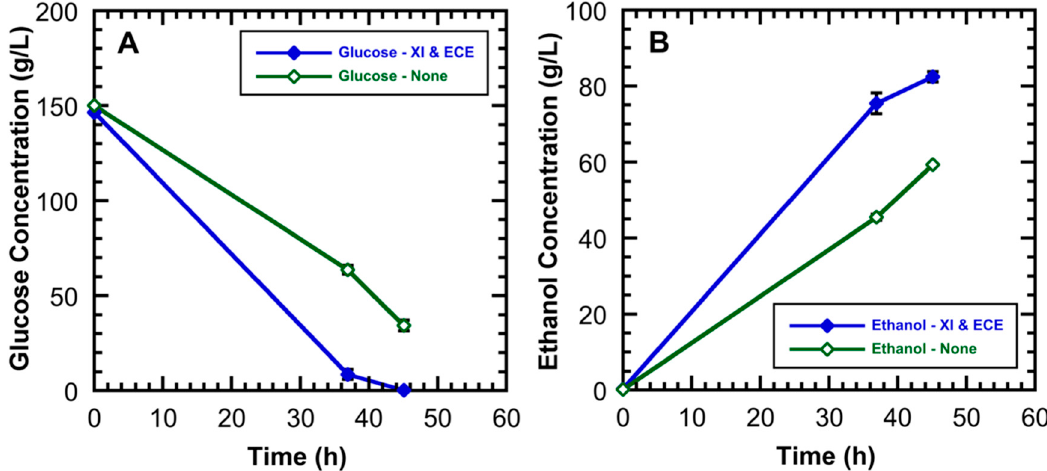
Figure 6. E ff ect of ECE and xylose isomerase on glucose consumption and ethanol productivity by S. pastorianus . ( A ) Glucose; ( B ) ethanol. S. pastorianus were cultured on hydrolysate with and without the ECE and xylose isomerase to determine if the species was significant to high gravity hydrolysate fermentation outcomes. Both ECE and xylose isomerase (ECE & XI, (cid:7) ); No ECE or xylose isomerase (None, ). Duplicate cultures for both conditions were conducted. Error bars represent the standard deviation, which have been included on all data points, but are di ffi cult to see in many cases due to the relative size of the bars to the symbols.